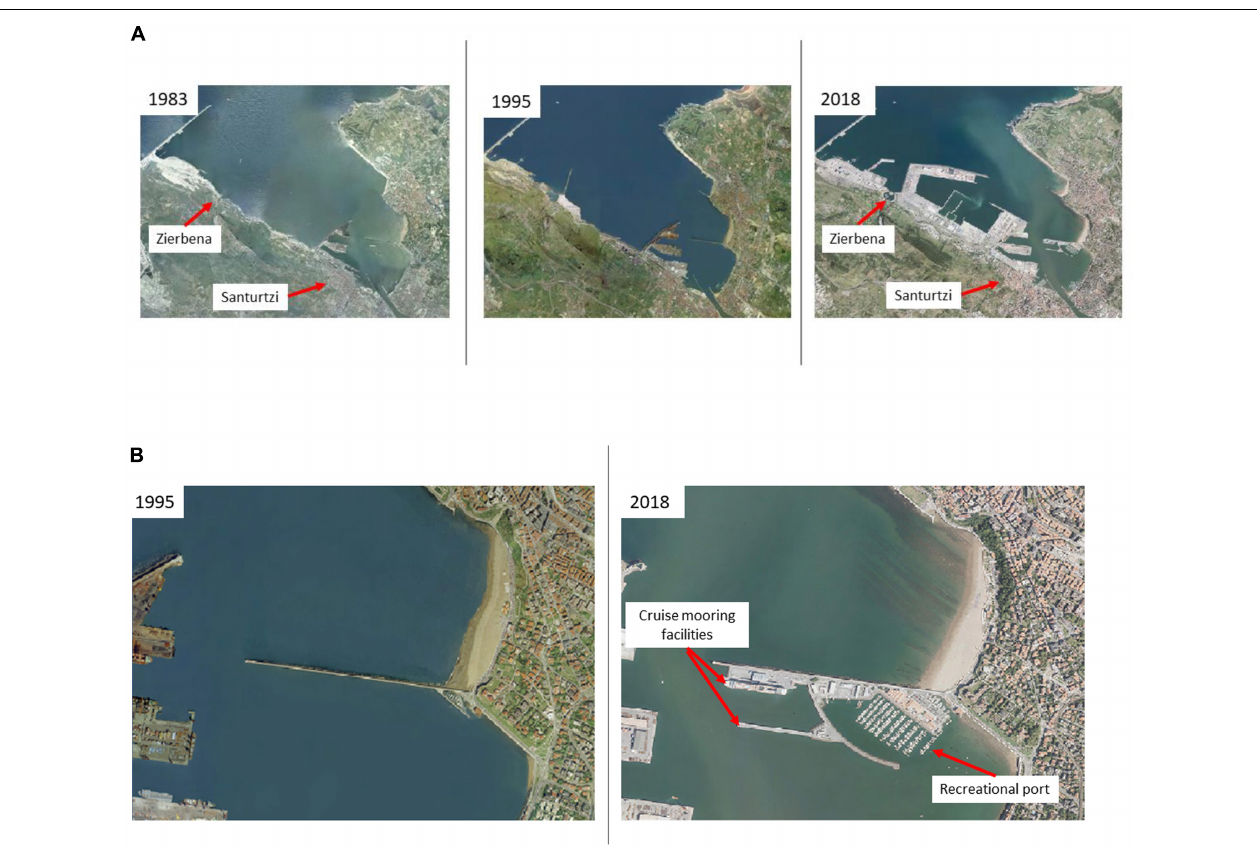
FIGURE 6 | Main morphological changes in the outer estuary. (A) 1983 (left), 1995 (middle), and 2018 (right) orthophotos showing the expansion of the industrial port facilities in the left bank. (B) 1995 (left) and 2018 (right) orthophotos showing the changes caused by the construction of the recreational port and cruise mooring facilities in the right bank. Source: GeoEuskadi Orthophoto Comparator